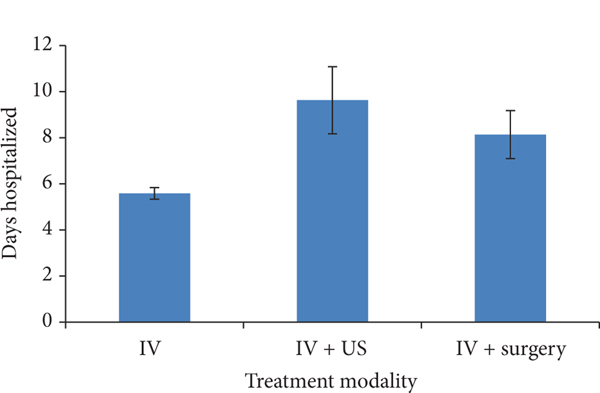
Mean duration of hospitalization in days with standard errors for comparisons between treatment modalities. Duration of hospitalization was different between all groups (P < 0.001). Post hoc pairwise comparison using Bonferroni’s correction showed the significant difference for duration of hospitalization between the IV group and the IV/US group (P < 0.001).